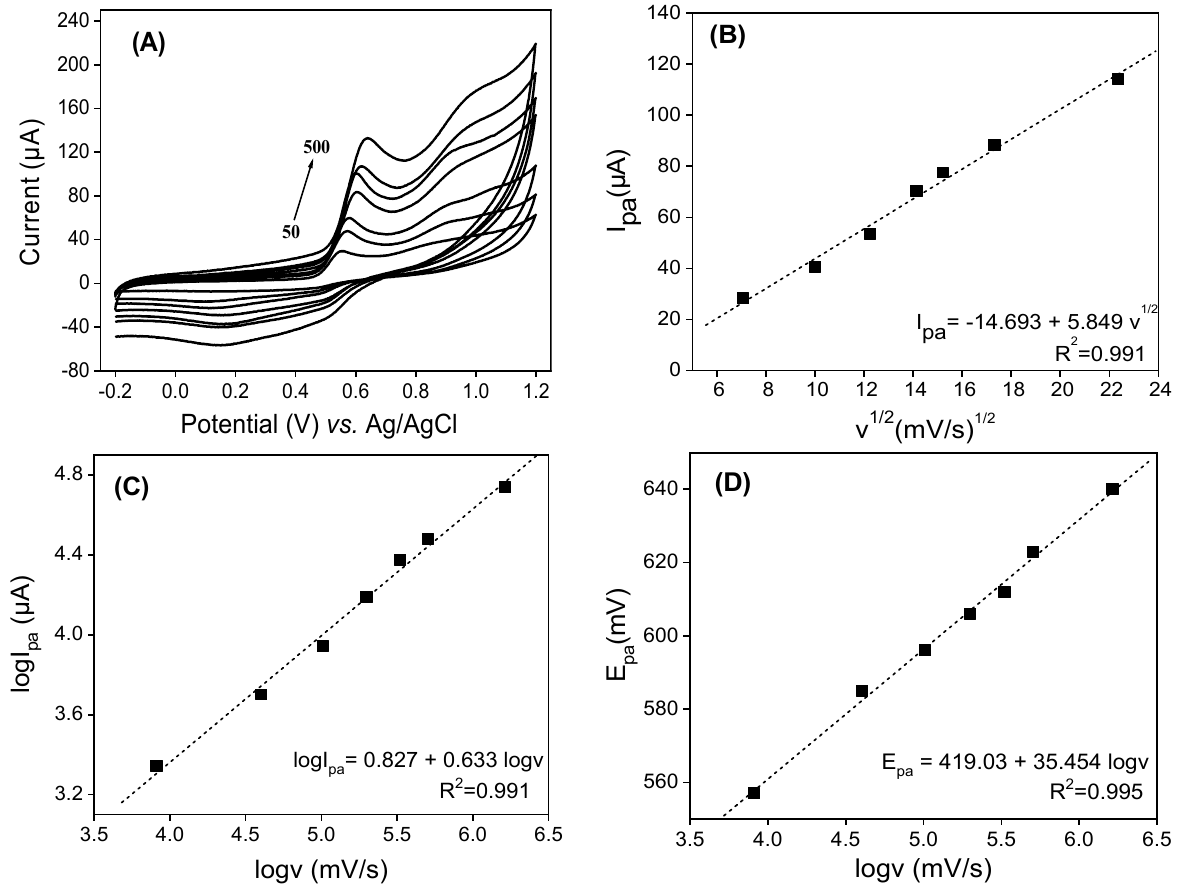
Figure 6. ( A ) Variations in scan rate on LaNH 3+ /GCE immersed in 0.1 M of 50:50 (v/v) phosphate buffer and EtOH mixture solution (pH = 2) in the presence of 5 × 10 − 4 M of QCT. ( B ) A plot of I pa = f (v 1/2 ). ( C ) A plot of logI pa = f (logv). ( D ) A plot of E pa = f (logv).